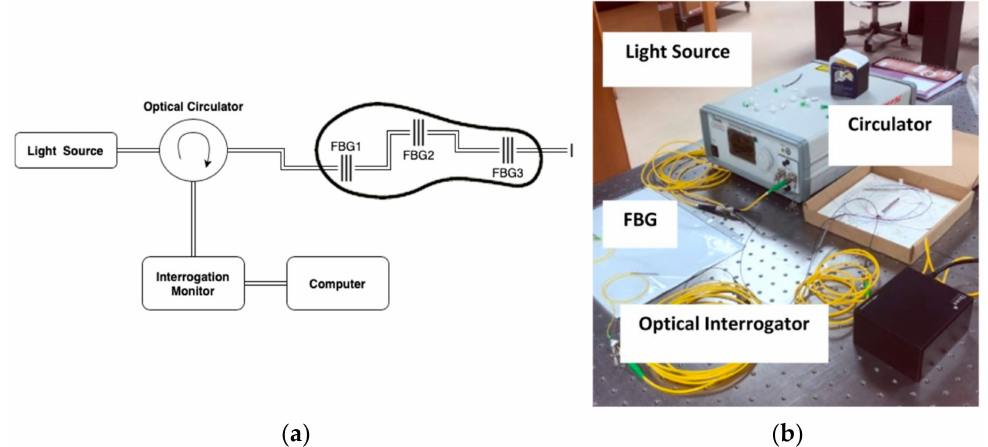
Figure 8. ( a ) Schematics of the experimental setup; ( b ) experimental setup at the lab.